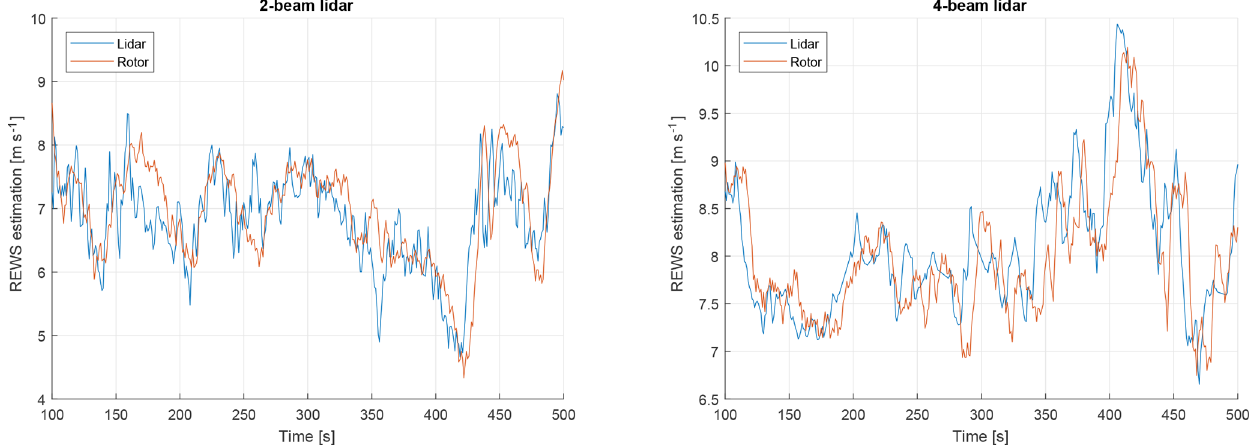
Figure 8. Time series example of lidar and turbine estimates of REWS. A high degree of similarity between the signals can be seen. Also, the preview ability of the lidar system is evident.